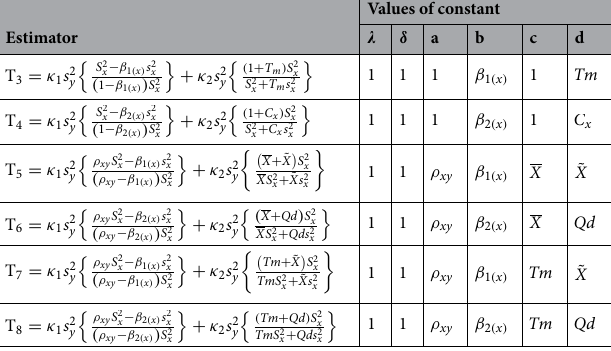
Table 1. Some members of class of